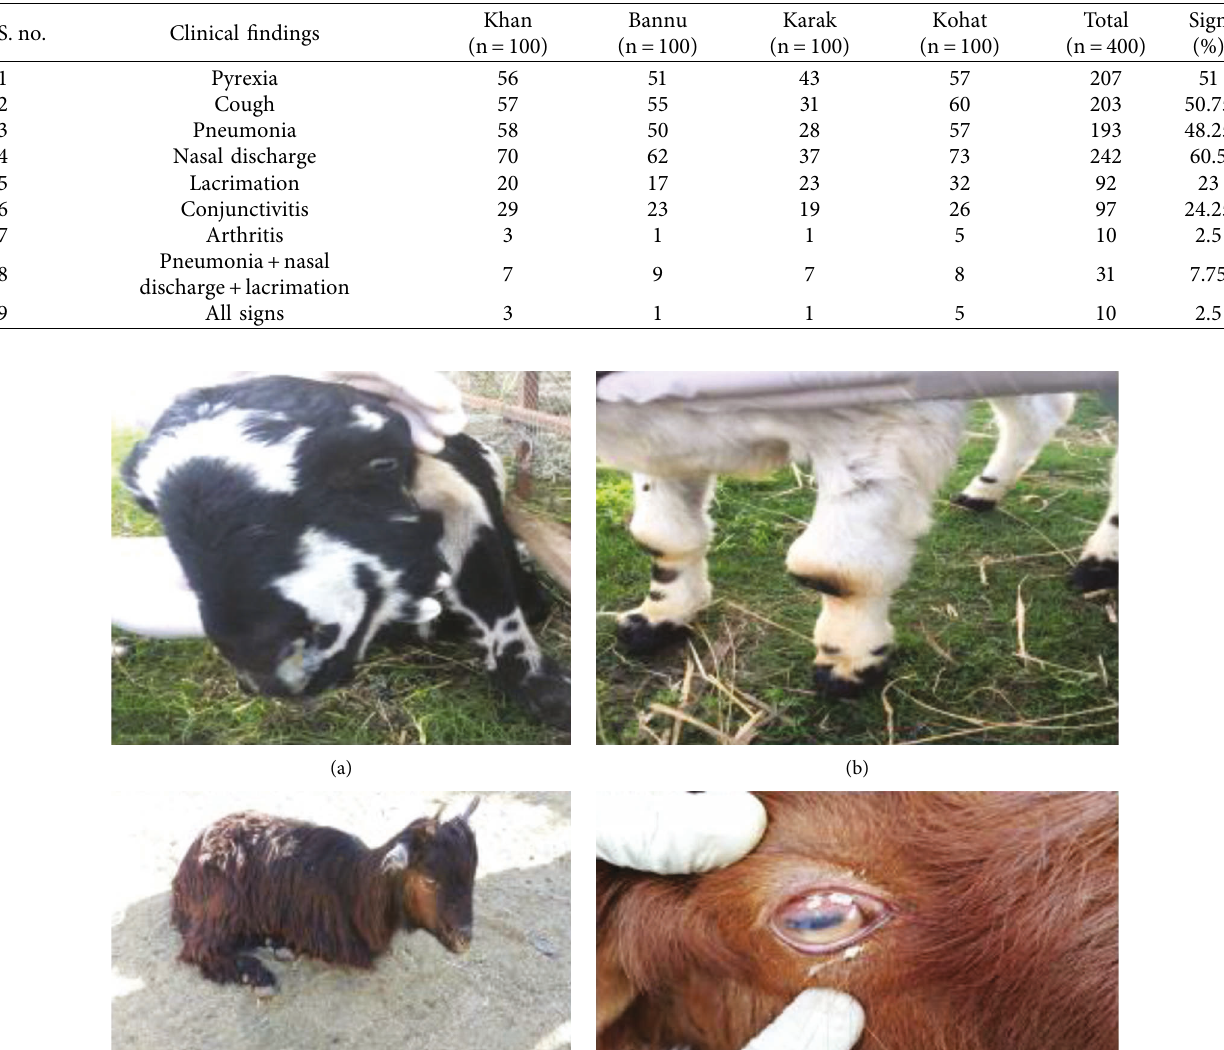
Figure 4: Graphical representation of total prevalence of Mycoplasma capricolum subsp. capripneumoniae by PCR in southern areas of KPK. Table 5: Percentage of clinical signs in naturally infected goats suffering from respiratory syndrome in southern areas of Khyber Pak- htunkhwa, Pakistan.